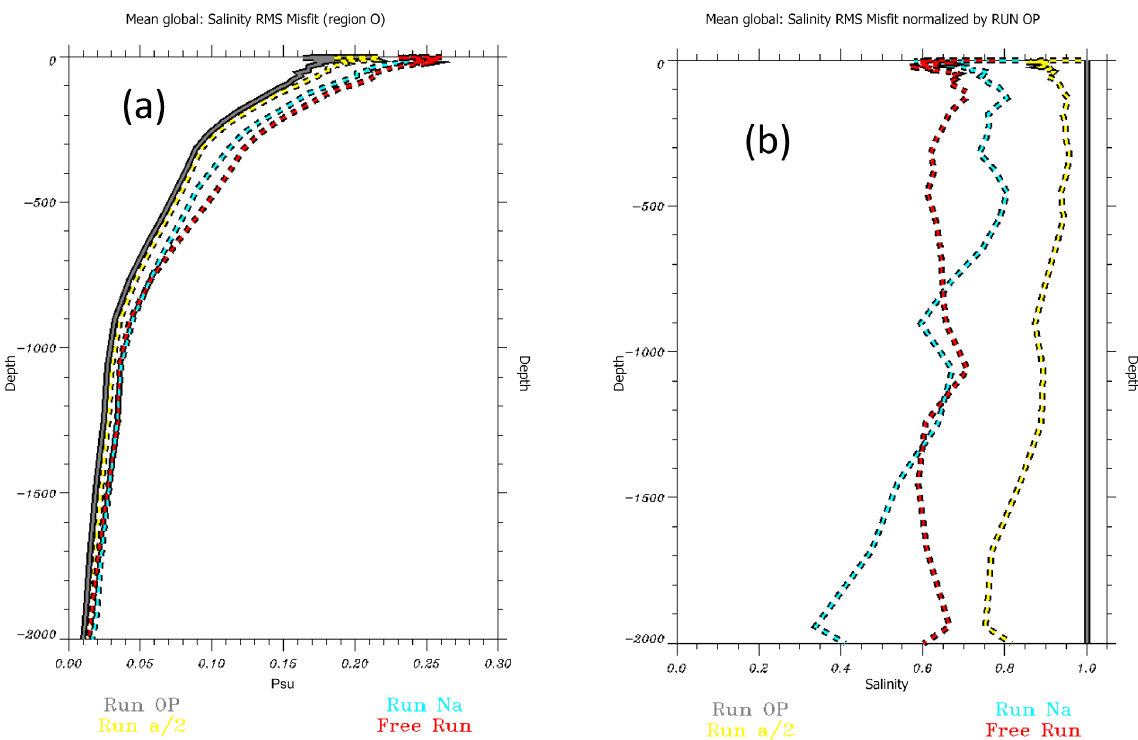
Figure 16. Vertical structure of the RMS of salinity innovations (a) and normalized RMS of salinity innovations (b) from 0 to 2000m for Run-Ref (grey), Run-Argo2 (yellow), Run-NoArgo (blue) and Free Run (red) over the last 6 months of the